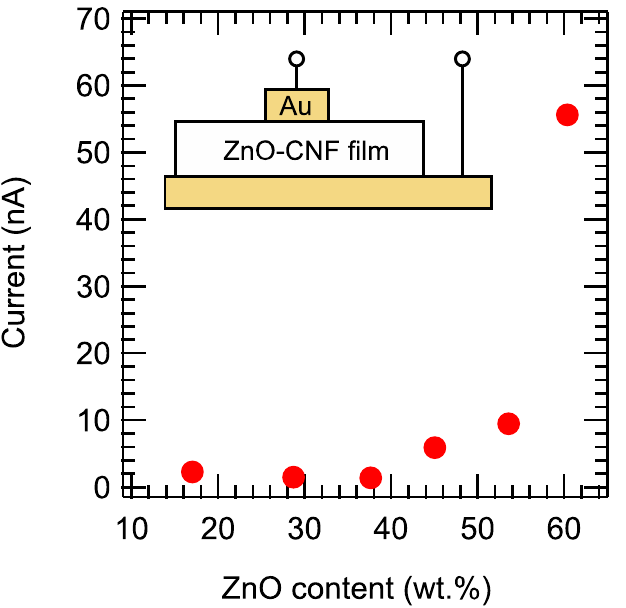
Figure 4. Current through the ZnO–CNF nanocomposite films as a function of the ZnO content at a constant voltage of 1.2 V. Inset: Schematic illustration of the measurement setup.